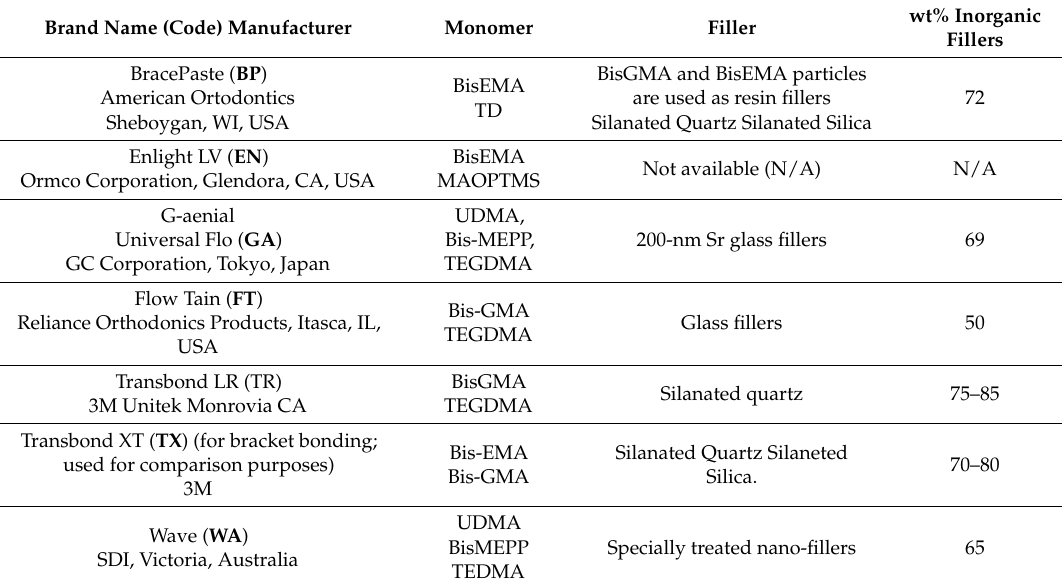
Table 1. Commercial names, manufacturers, monomers, filler type, filler loading, and codes of materials